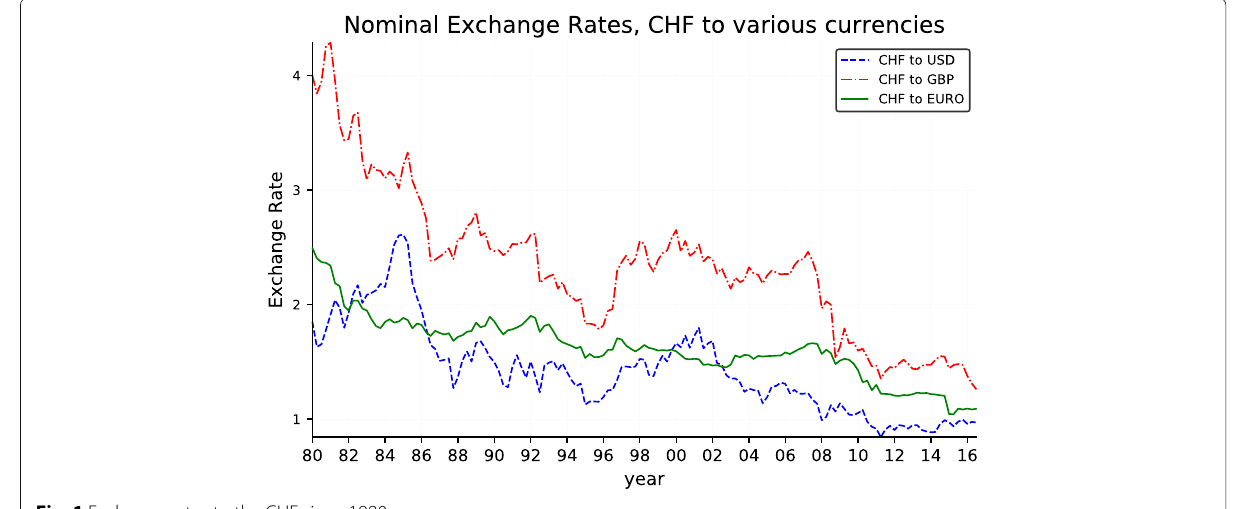
Fig. 1 Exchange rates to the CHF since 1980